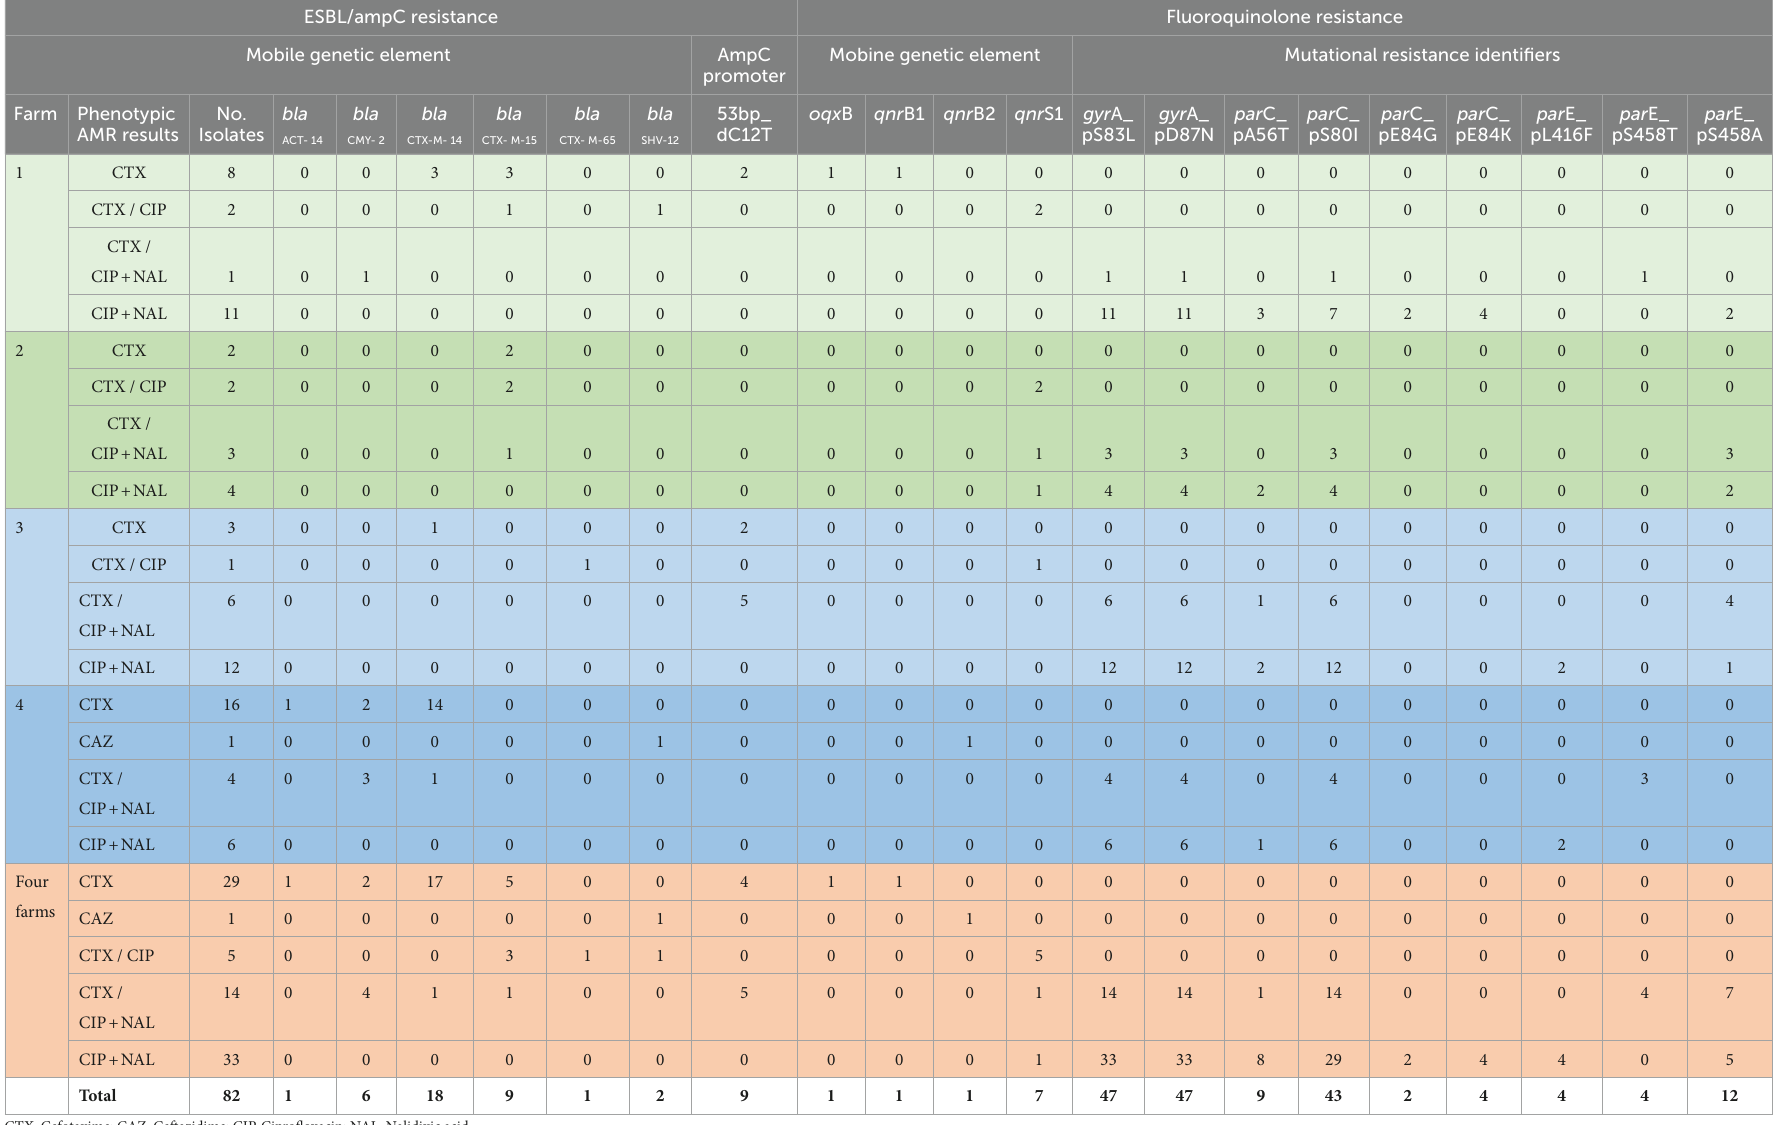
TABLE 1 Distribution of genes associated with cefotaxime/ceftazidime and fluoroquinolone resistance amongst isolates from wastewater from four Irish farms. ESBL/ampC resistance Fluoroquinolone resistance Mobile genetic element AmpC Mobine genetic element Mutational resistance identifiers promoter Farm Phenotypic AMR